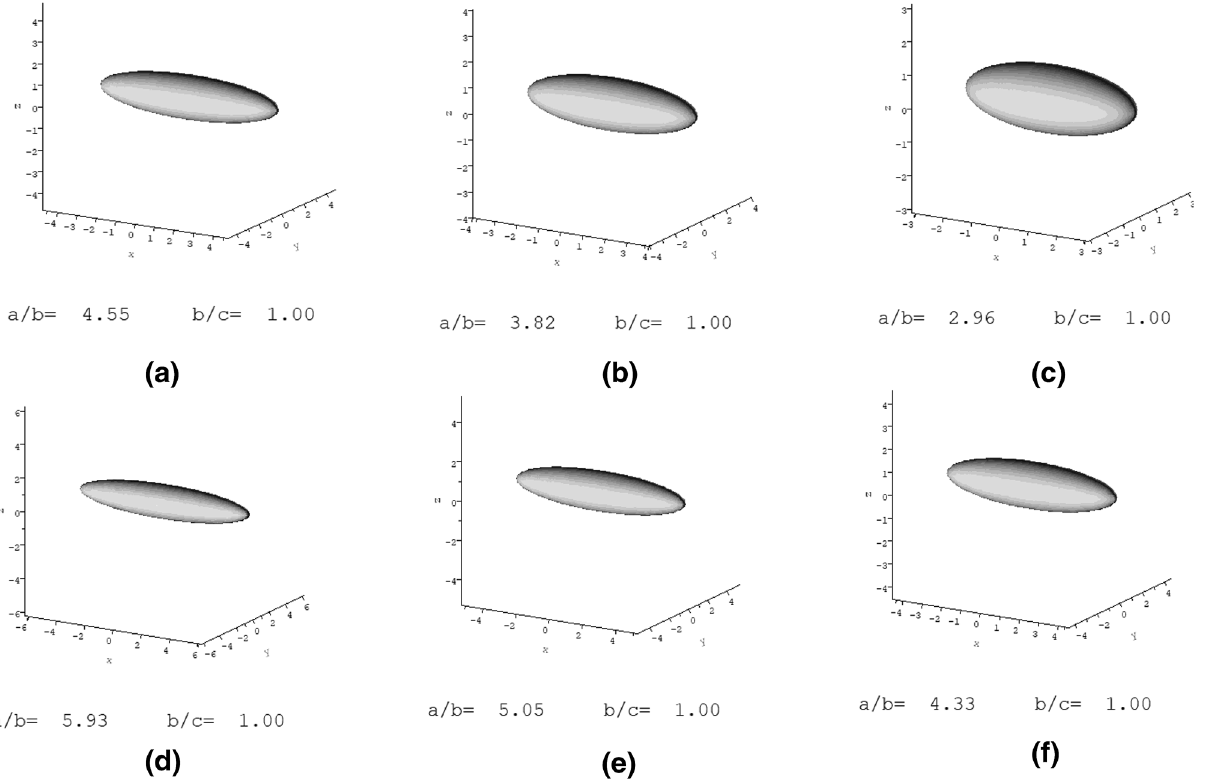
Figure 7. Ellipsoidal representations from the conformation analyses of TPA5 in isopropanol, using ELLIPS1. ( a ) P for a ( v s / ¯ v ) = 1.0; ( b ) P for a ( v s / ¯ v ) = 1.2; ( c ) P for a ( v s / ¯ v ) = 1.4; ( d ) ν for a ( v s / ¯ v ) = 1.0; ( e ) ν for a ( v s / ¯ v ) =